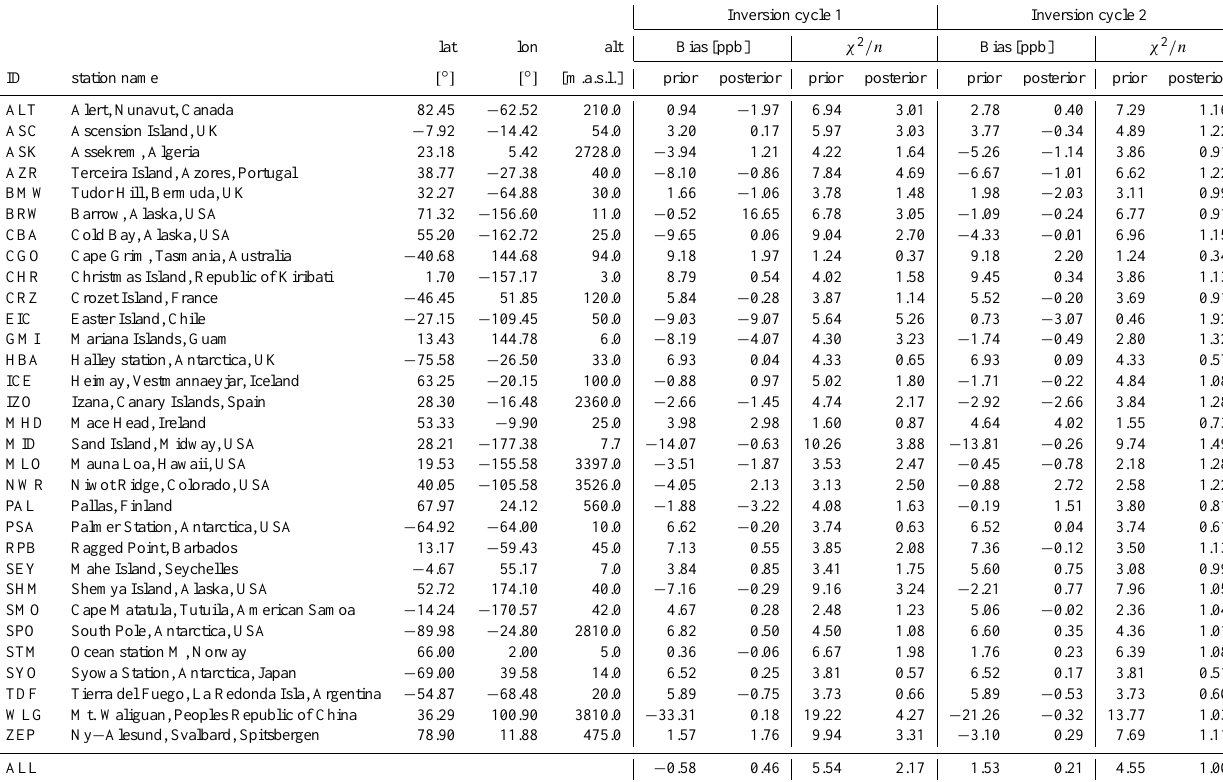
n (cid:0) y o (cid:1) , where n is the number of observations per station and σ P − y m n i i i = 1